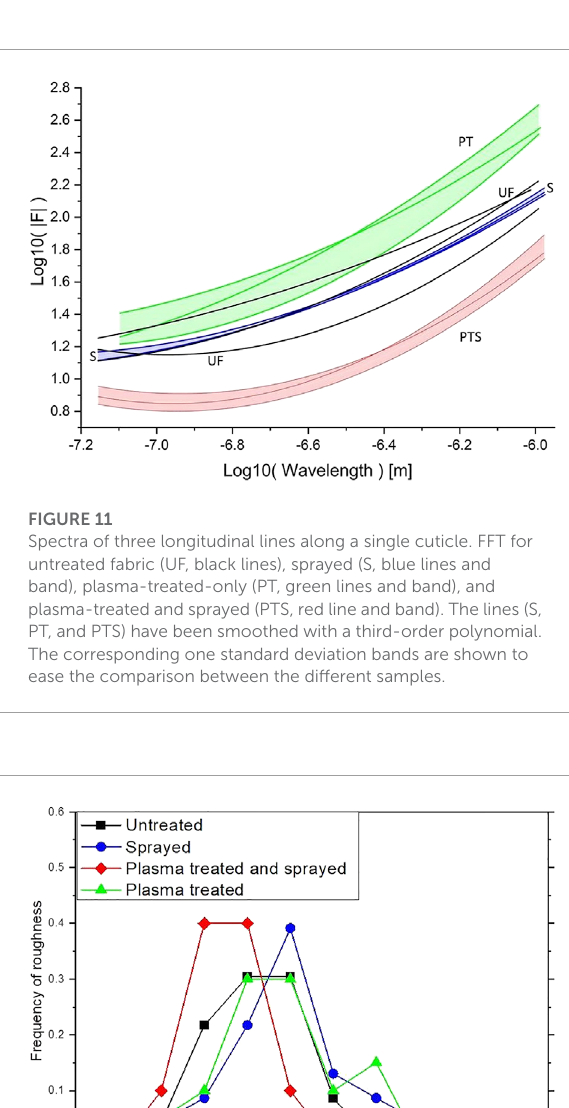
in the figures. All values of α and their spread are consistent within the precision obtained from the single fits. Together with the direct visual inspection of samples and their SEM images, we may conclude that the effect of plasma treatment, resin spraying, and both on large-scale structure is minimal. This confirms that the structure of the cuticle was not altered, in agreement with the overall assessment of SEM imaging, where significant instances of fiber breaking or cuticle fracturing were never